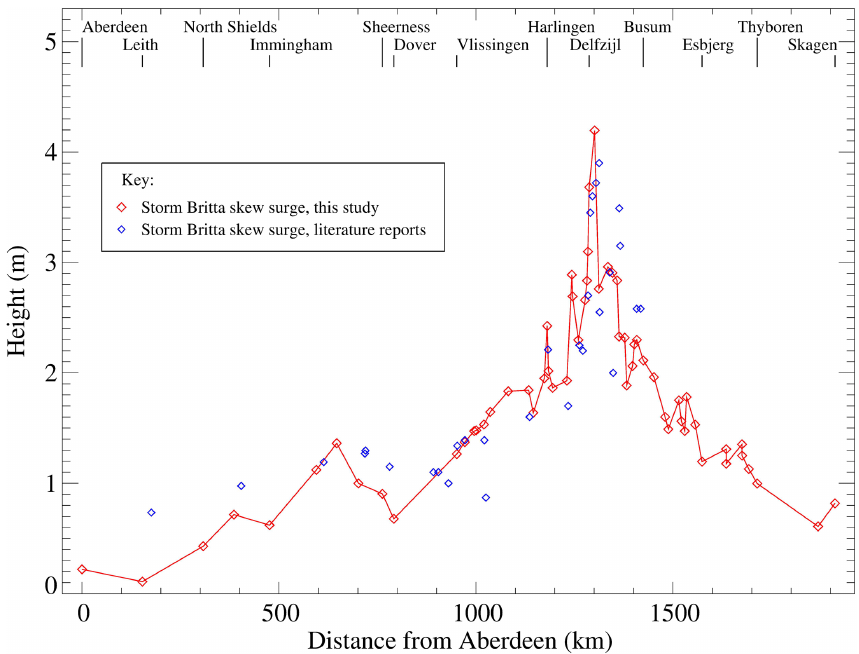
Figure 3. Skew surge for Storm Britta with published values for comparison.